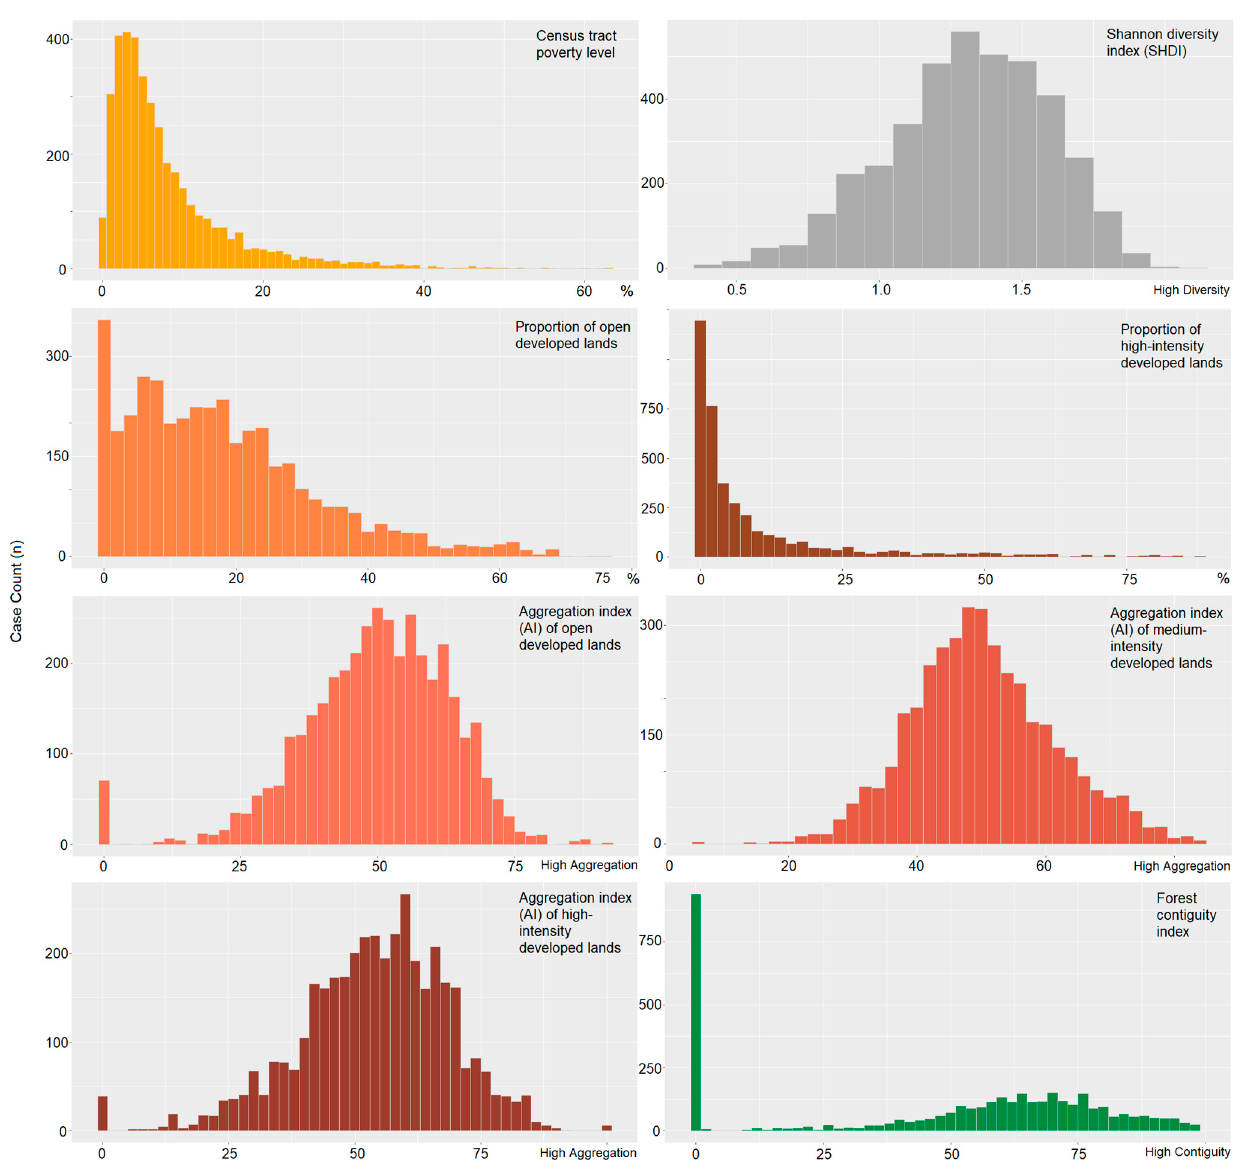
Figure 4. Distribution of colon cancer patients by neighborhood/landscape characteristics.